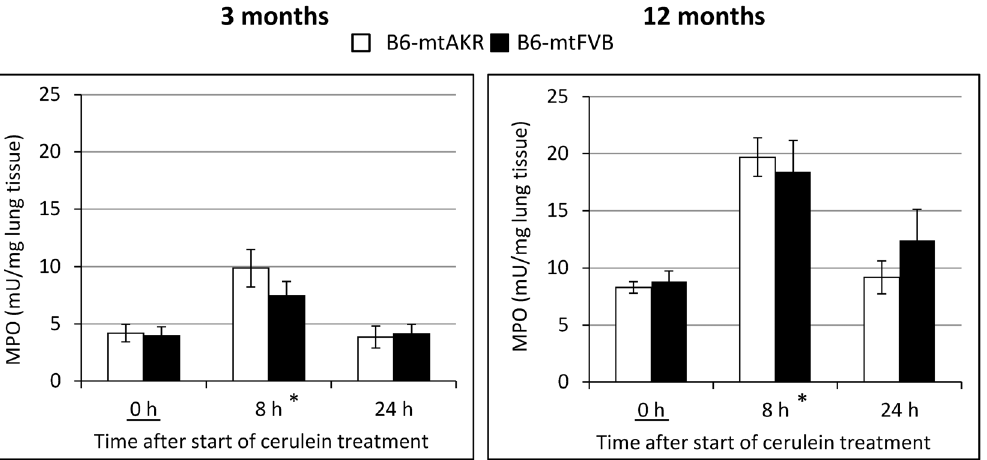
Figure 5. MPO activities in lung tissue of cerulein-treated B6-mtAKR and B6-mtFVB mice. Lung tissue of 3-month-old mice and 12-month- old animals at the indicated time points after initiation of cerulein treatment (n=5–6 per per time point, strain and age group) was subjected to the quantification of MPO activity as described in the ‘‘Materials and Methods’’ section. Data are expressed as mU/mg wet weight (mean 6 SEM). *P U =0.007 and , 0.001, resp., vs. 0 h (Bonferroni-adjusted a =0.0166).